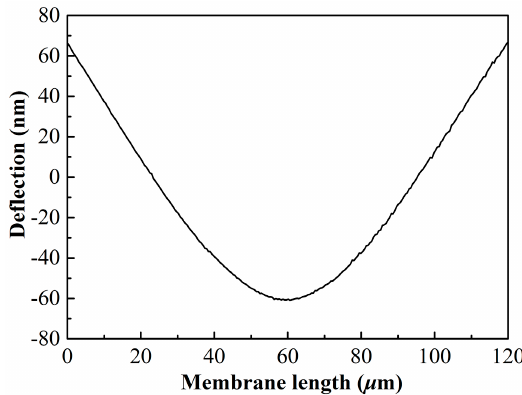
Figure 7. Static deflection profile measured along the CMUT width though the center of the membrane under atmospheric pressure.